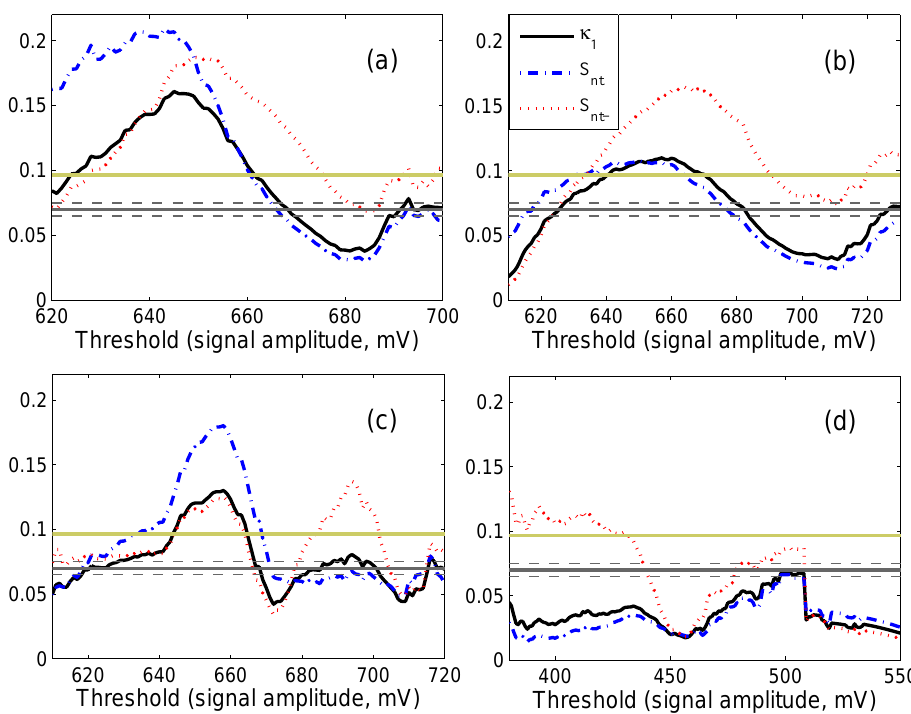
Figure 6. Natural time analysis results obtained for the MHz EME signals shown in (a) Fig. 2a, recorded at the Cephalonia station prior to EQ1, (b) Fig. 3a, recorded at the Zante station prior to EQ1, (c) Fig. 4a, recorded at the Cephalonia station prior to EQ2, and (d) Fig. 5a, recorded at the Zante station prior to EQ2. The quantities κ 1 (solid curve), S nt (dash-dot curve), and S nt- (dot curve) vs. amplitude threshold for each MHz signal are shown. The entropy limit of S u ( ≈ 0 . 0966 ) , the value 0 . 070, and a region of ± 0 . 005 around it are denoted by the horizontal solid light green, solid grey, and grey dashed lines, respectively. (For interpretation of the references to colours, the reader is referred to the online version of this